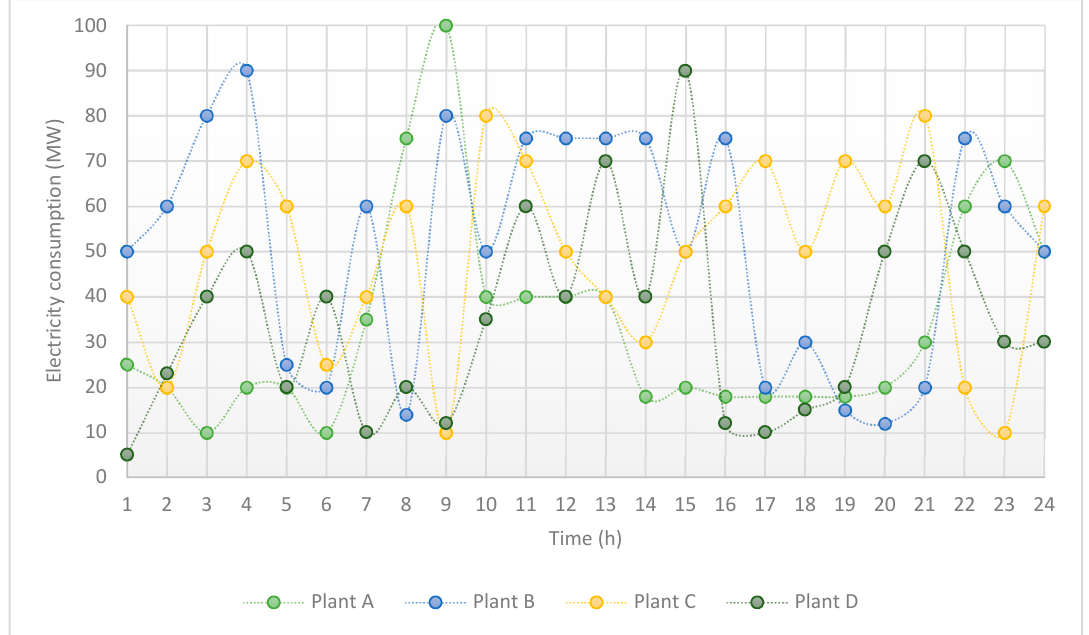
Figure 3. Power variations for Industrial Plants A to D in 24 h operations [8,43].